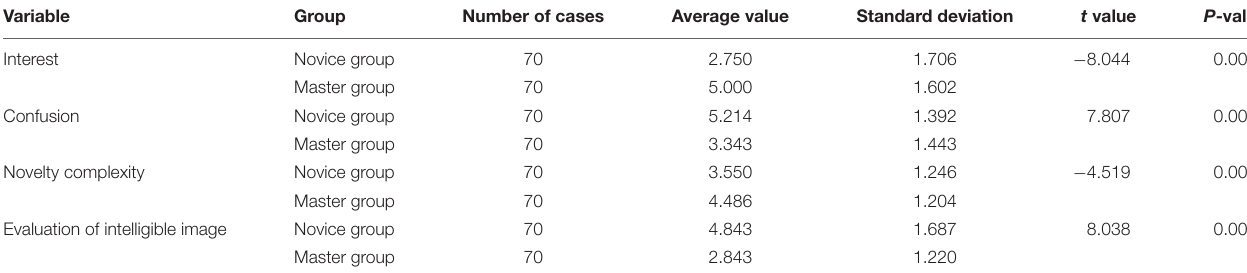
TABLE 2 | Independent samples t -test.